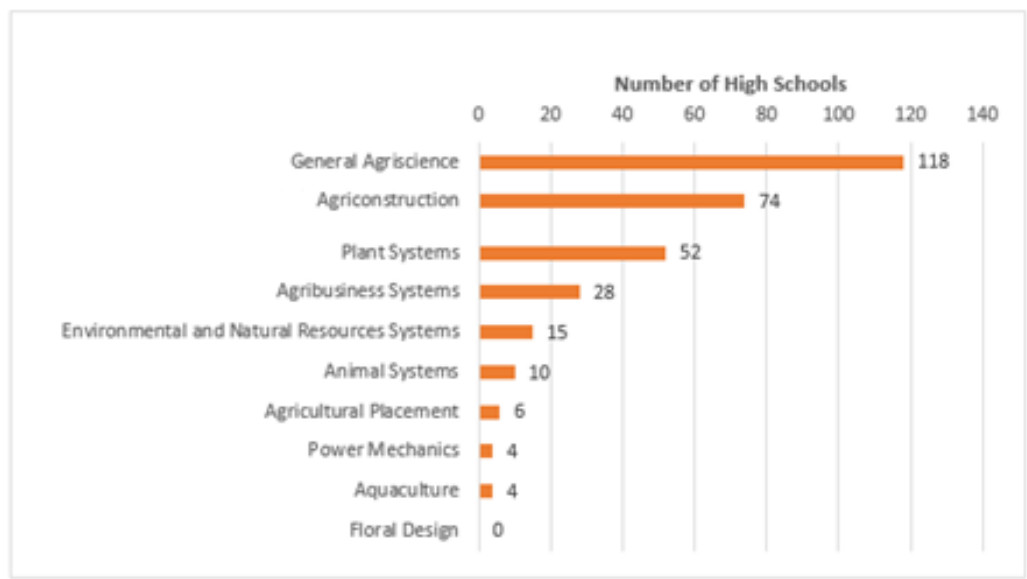
Figure 3. The frequencies of agriculture-related courses in Alabama’s high schools.